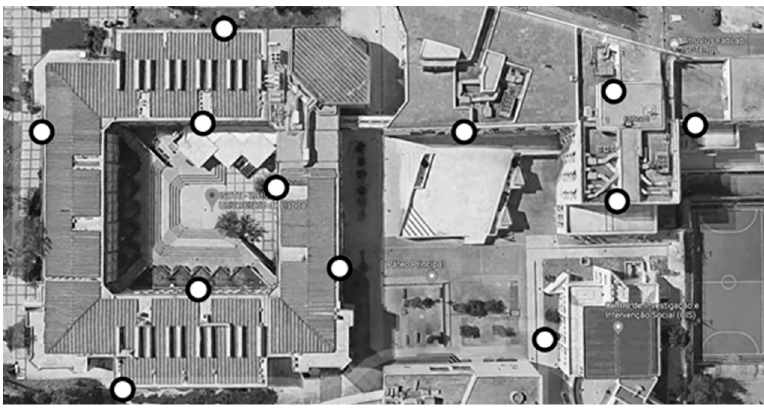
Figure 5. Placement of external temperature and humidity sensors.